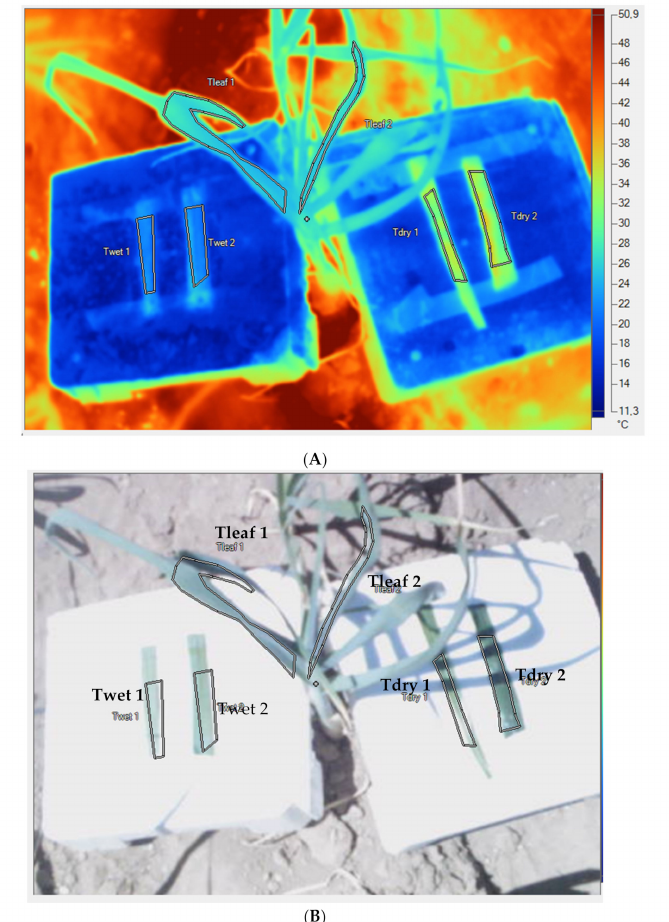
Figure 2. ( A ) Thermal image of a garlic plant and ( B ) corresponding visual (RGB) image. The marked polygons show the selected area of canopy and reference surfaces from which the average temperature is obtained by the SmartView software (Fluke Smartview 4.3, Fluke Corporation, Everett, WA, USA). Finally, processed data were used to calculate the crop water stress index (CWSI) as: Tleaf − Twet CWSI = Tdry − Twet Bulbs were harvested at the end of the growth cycle, when the three youngest leaves were dry. Afterwards, bulbs were stored in a ventilated warehouse and weighed until constant weight to the nearest mg. At the same time, bulb diameter was measured with a